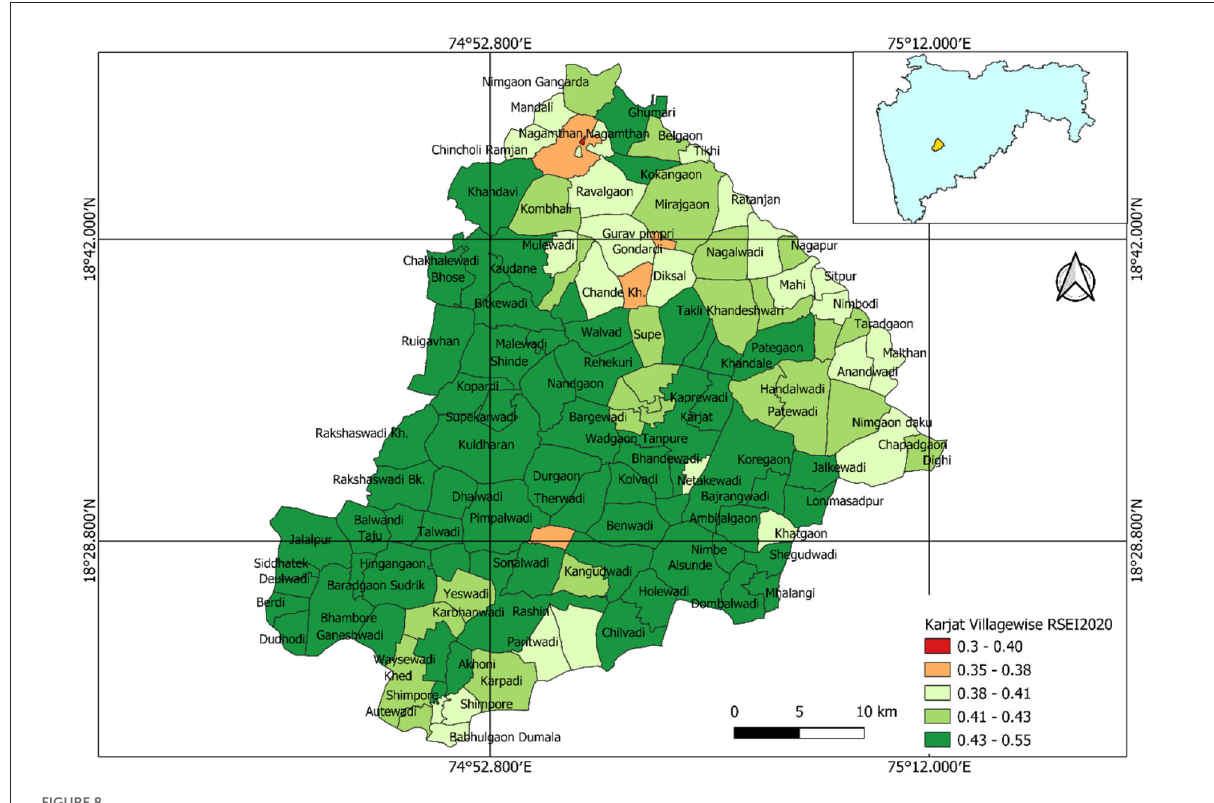
FIGURE8 Village-wise RSEI of Karjat taluka for the year